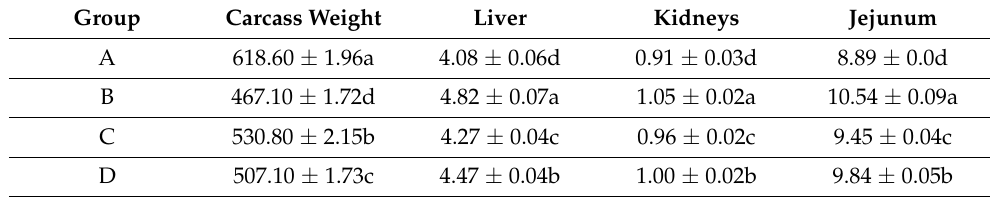
Table 4. Relative weight of various organs (g) in the first sacrifice (Mean ± SD). Group